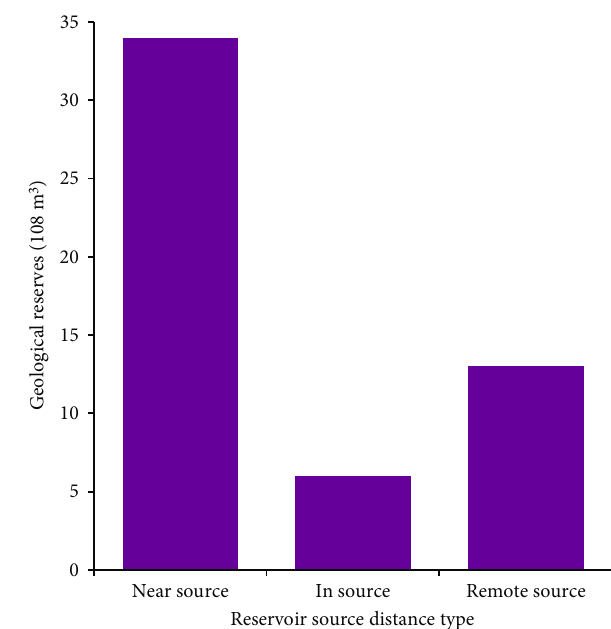
Figure 3: Geological reserves of natural gas at di ff erent reservoir- source distances in Upper Paleozoic. Table 3: Statistics of Paleozoic reservoir facies types.